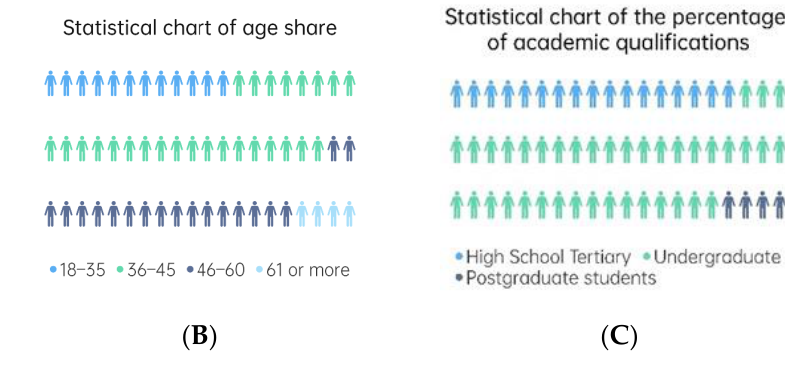
Figure 3. Statistical chart of the questionnaire data. ( A ) Statistical chart of the percentage of men and women. ( B ) Statistical chart of age share. ( C ) Statistical chart of the percentage of academic qualifications.